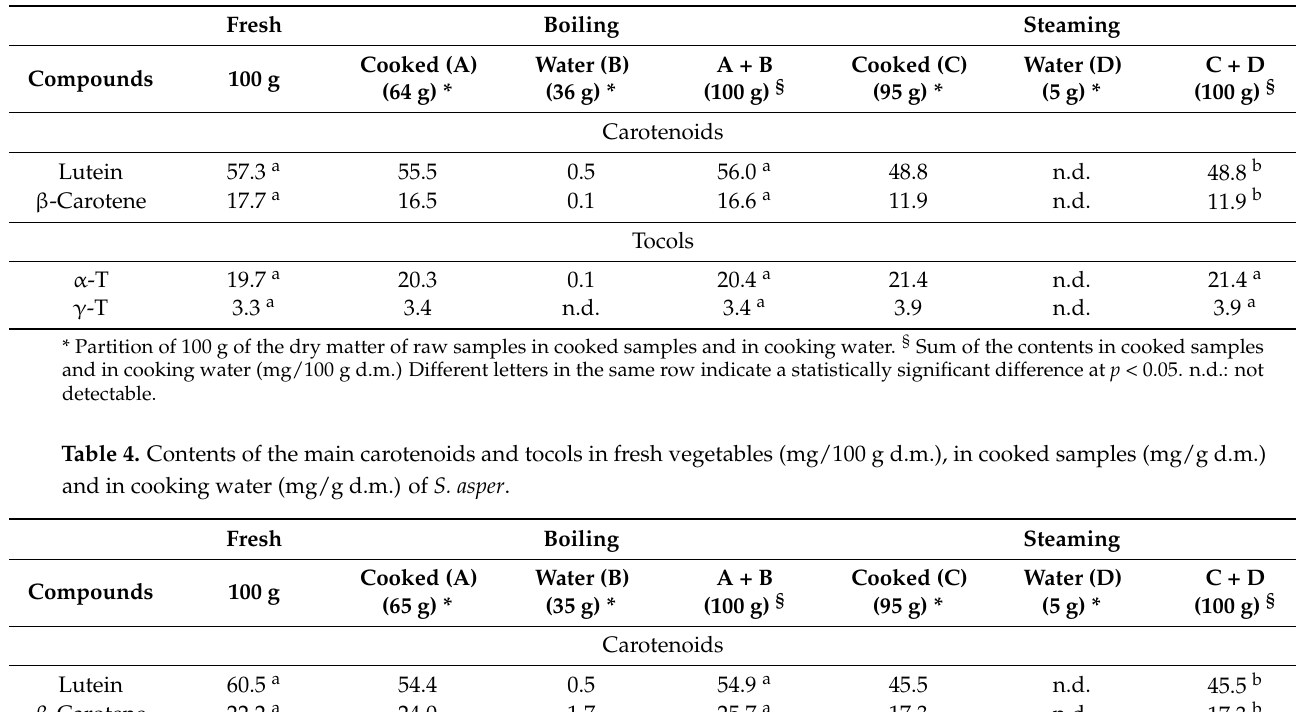
Table 3. Contents of the main carotenoids and tocols in fresh vegetables (mg/100 g d.m.), in cooked samples (mg/g d.m.) and in cooking water (mg/g d.m.) of S. oleraceus.